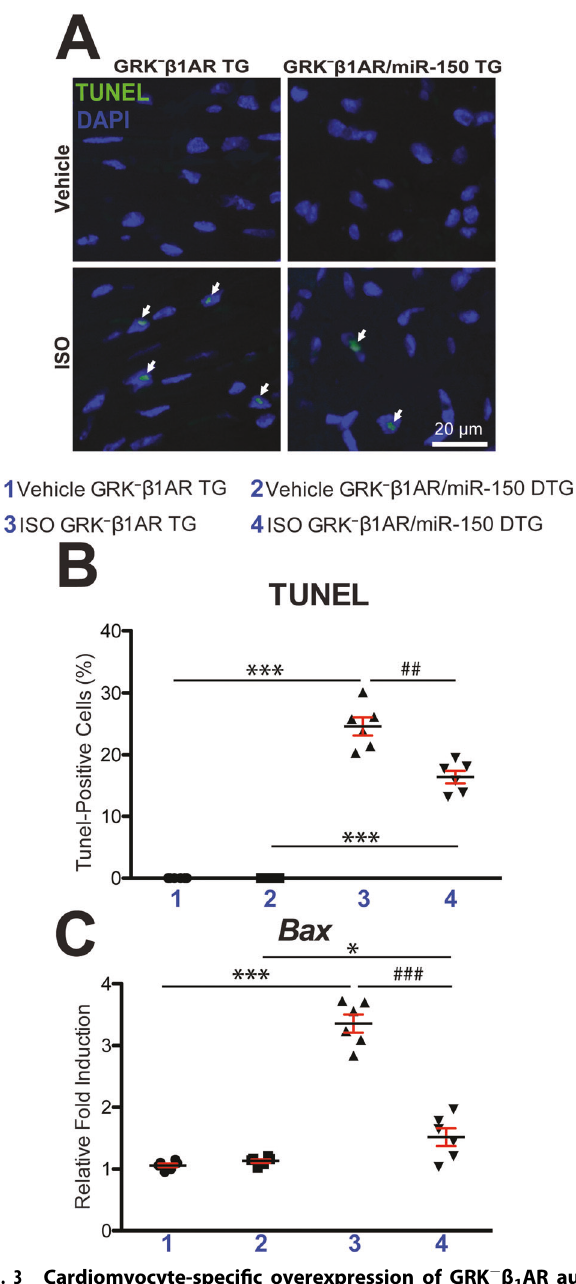
Fig. 3 Cardiomyocyte-speci fi c overexpression of GRK − β 1 AR aug- ments cardiac apoptosis after chronic isoproterenol treatment, which is repressed by miR-150. A , B Representative terminal deoxynucleotidyl transferase dUTP nick end labeling (TUNEL) staining images in heart sections at 1-week post-treatment ( A ) and apoptosis quanti fi cation in six 40× fi elds ( B ). Scale bar: 20 μ m. C QRT-PCR analysis of pro-apoptotic Bax expression in GRK − β 1 AR;miR-150 DTG hearts compared to GRK − β 1 AR TG controls at 1-week post-treatment. N = 6 per group. Data are presented as fold induction of gene expression normalized to Gapdh . Two-way ANOVA with Tukey multiple compar- ison test. * P < 0.05 or *** P < 0.001 vs. vehicle; ## P < 0.01 or ### P < 0.001 vs. ISO GRK − β 1 AR TG. All data are presented as mean ±